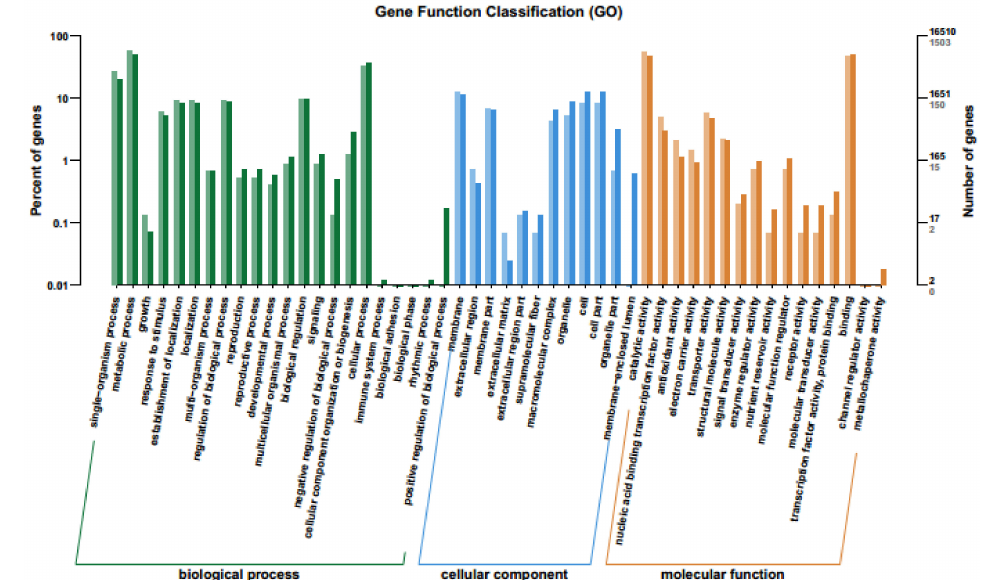
Figure 4. Differential gene ontology (GO) analysis of functional enrichment with up- and down-regulated DEGs between bml mutant and WT at early-tillering stage. The horizontal axis is the functional classification and the vertical axis is the number of genes in the classification ( right ) and the percentage of the total number of genes on the annotation ( left ). Different colors represent different classifications. Light colors on the histogram and axis represent differential genes, and dark colors represent all